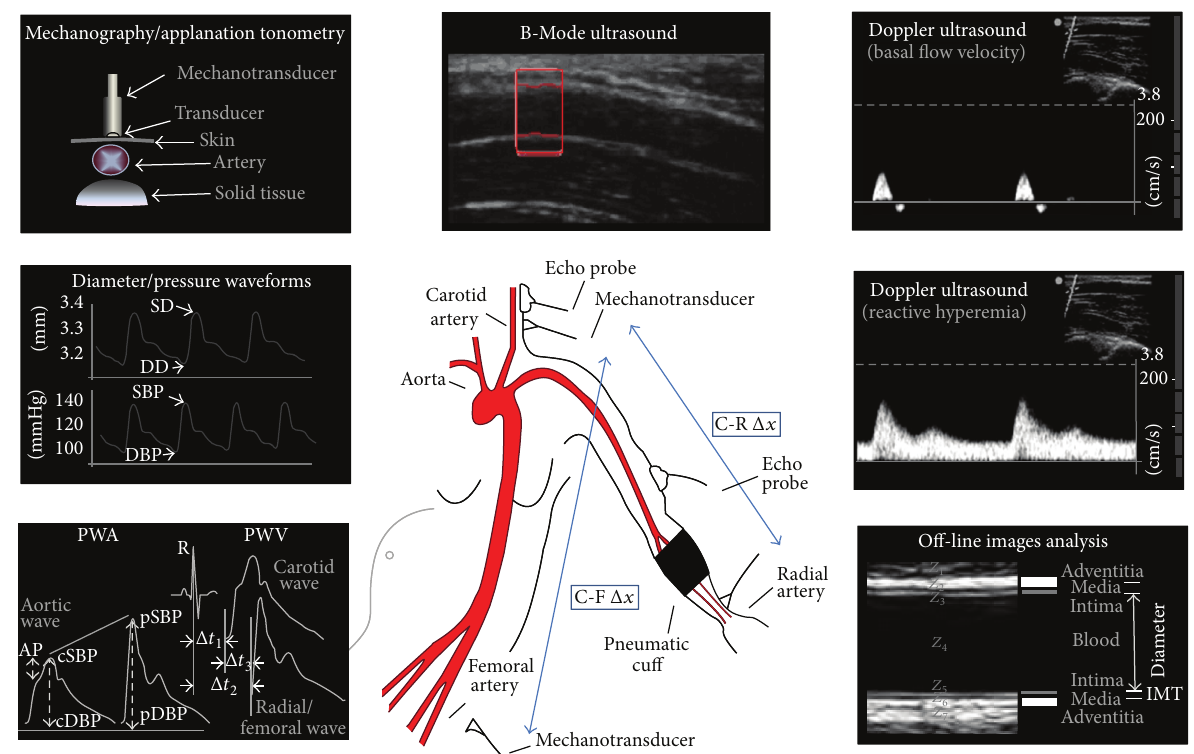
Figure 1: Schema of the instrumental approach employed to assess noninvasive arterial structure and function in basal and post-VRT conditions.Employedtechniquesareasfollows:carotid-to-femoralandcarotid-to-radialPWV(applanationtonometryandmechanography), PWA (applanation tonometry), arterial diameters and CIMT (B-Mode ultrasound), and blood flow velocities (Doppler ultrasound). PWA: pulse wave analysis; PWV: pulse wave velocity; AP: augmentation pressure; Δ𝑡 1 , Δ𝑡 2 : time delay between R wave from ECG and carotid foot wave and femoral/radial foot wave, respectively; Δ𝑡 3 : time delay between carotid foot wave and femoral/radial foot wave; cSBP/pSBP: central/peripheral systolic blood pressure; cDBP/pDBP: central/peripheral diastolic blood pressure; DD: diastolic diameter; SD: systolic diameter; CIMT: carotid intima-media thickness; 𝑍 : acoustic impedance; C-F and C-R Δ𝑥 : carotid-to-femoral and carotid-to-radial distance,